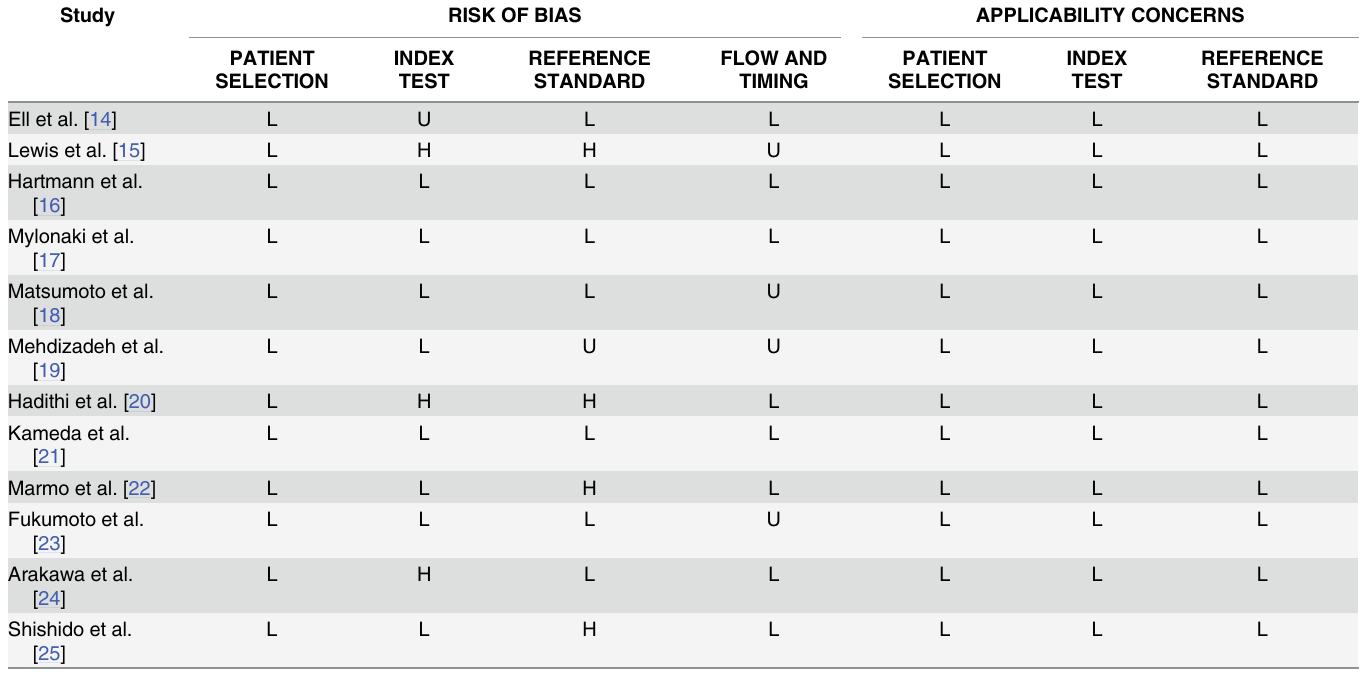
Table 2. Cochran risk of bias summary for the meta-analysis